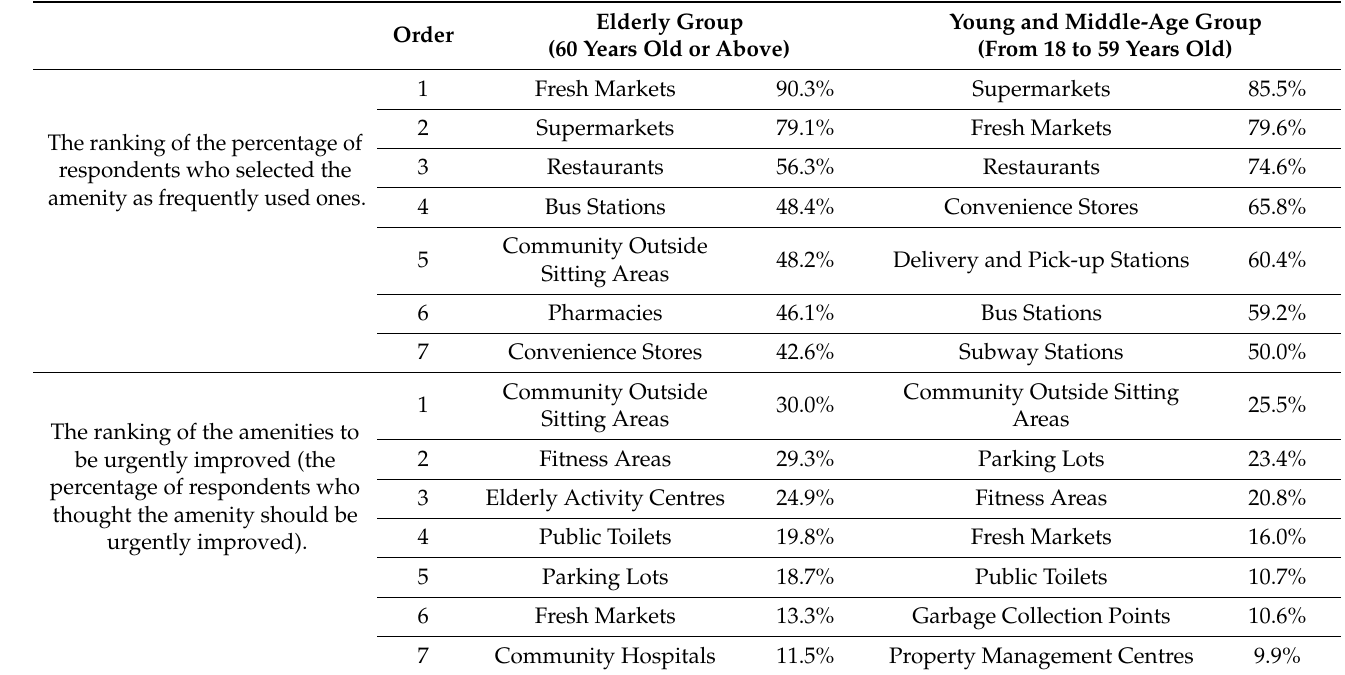
Table 3. The ranking of the rate of frequent usage and perceived to-be-improved amenities. Elderly Group Order (60 Years Old or Above)